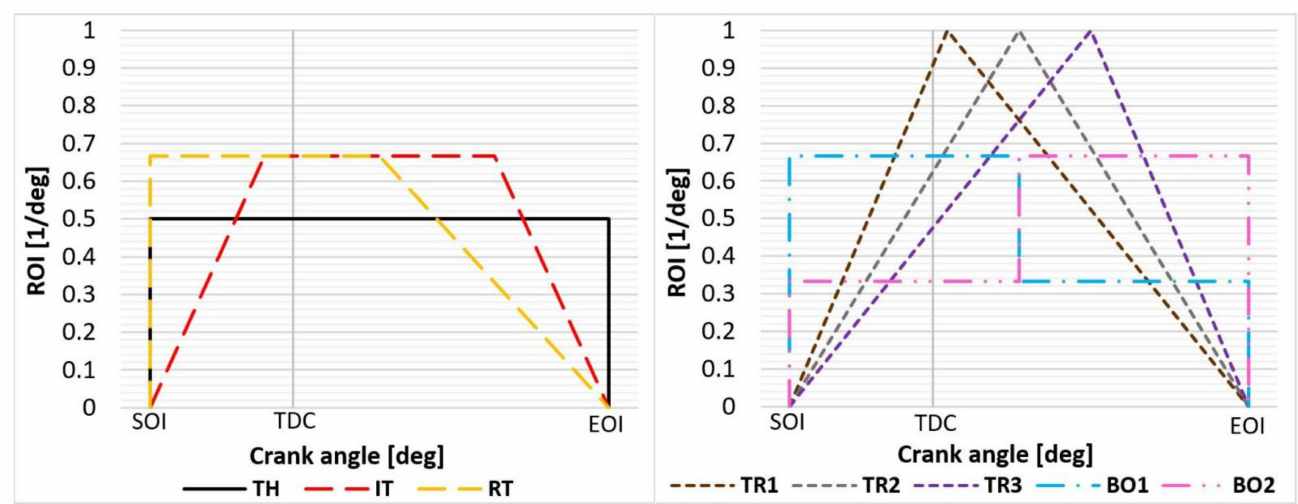
Figure 4. Original and modified rate of injection shapes under simulation